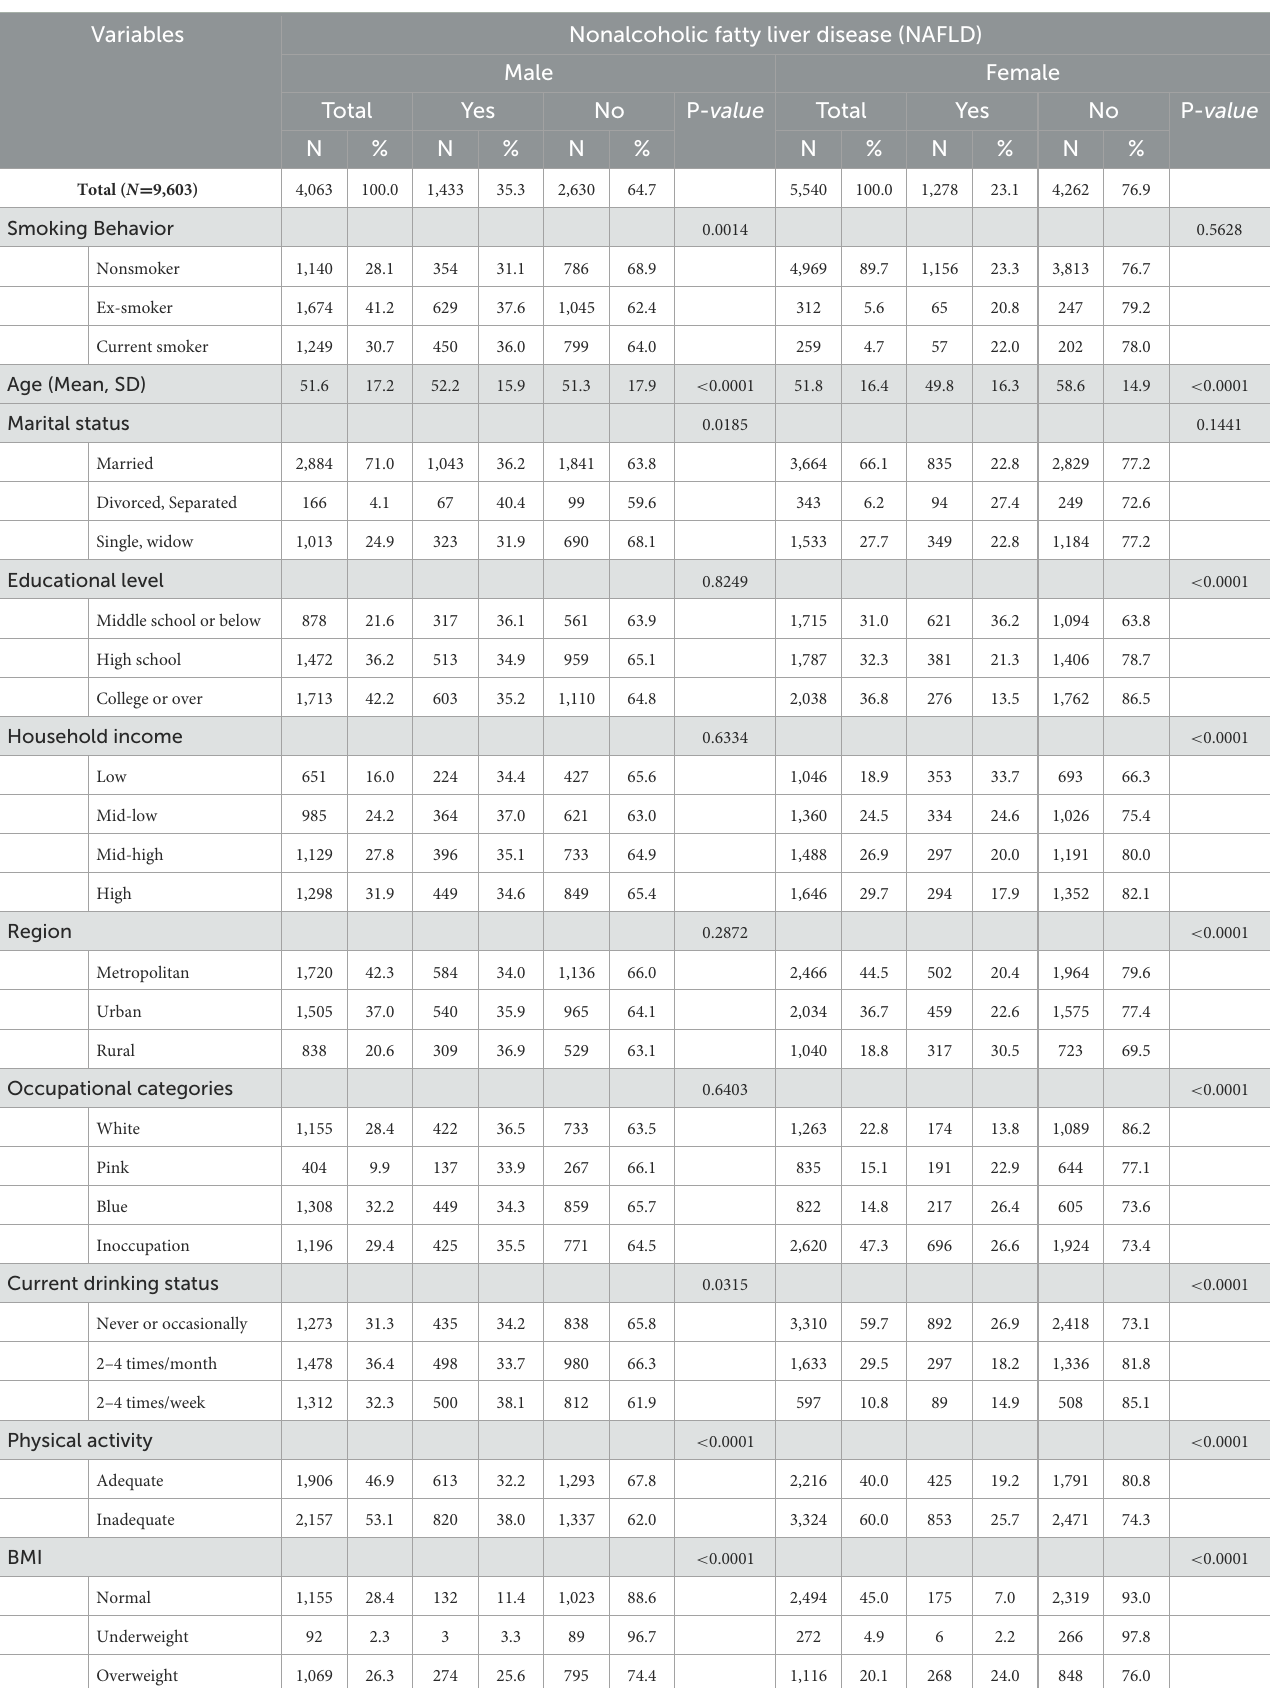
TABLE 1 General characteristics of the study